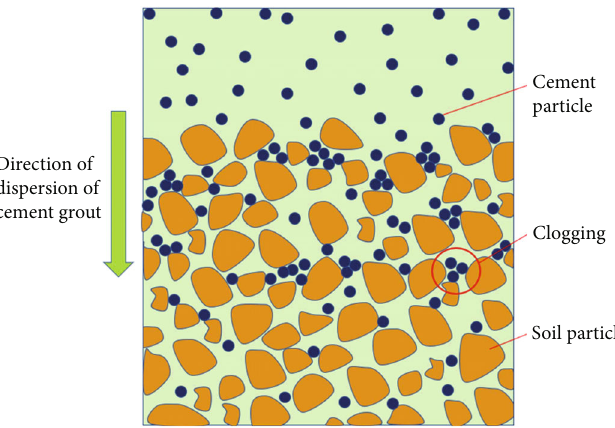
Figure 1: Schematic diagram of the fi ltration e ff